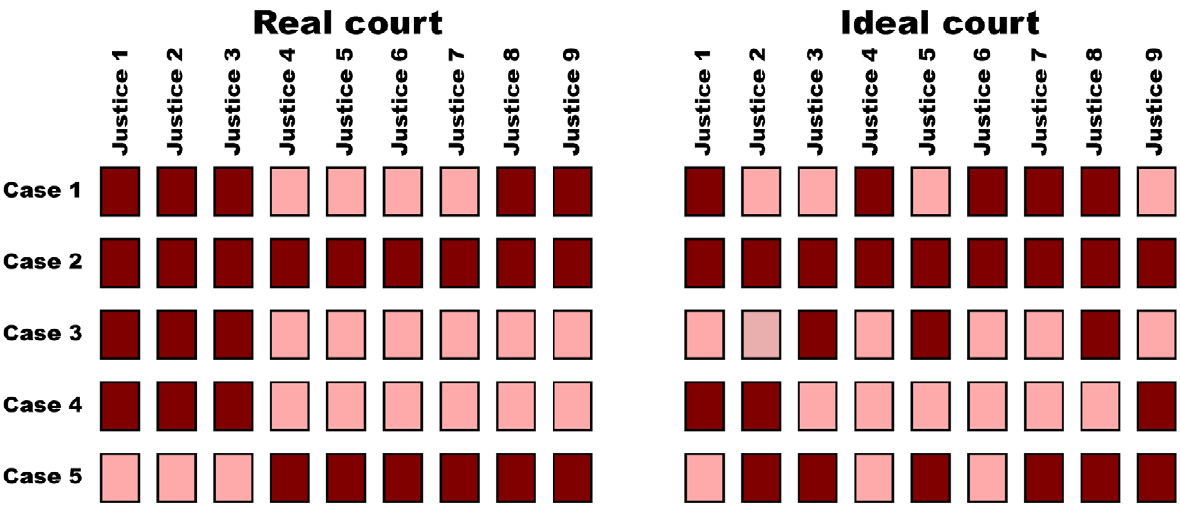
Figure 1. Court idealization. Each row represents the votes of the nine justices in a case (dark, agreement with the petitioner; bright, disagreement with the petitioner). We obtain the ideal court (right) from the real court (left) by randomly reshuffling, within each case, the votes of the justices so that the number of agreements and disagreements is preserved.